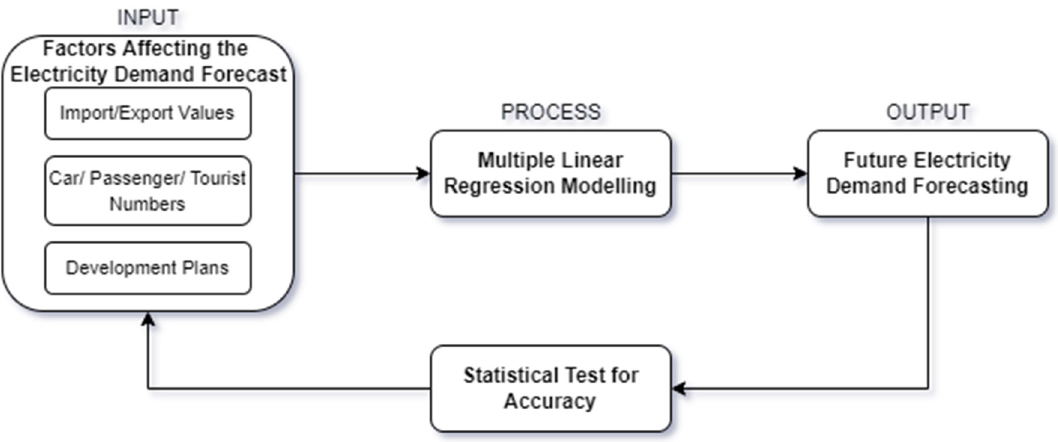
Figure 10. MLR flowchart.